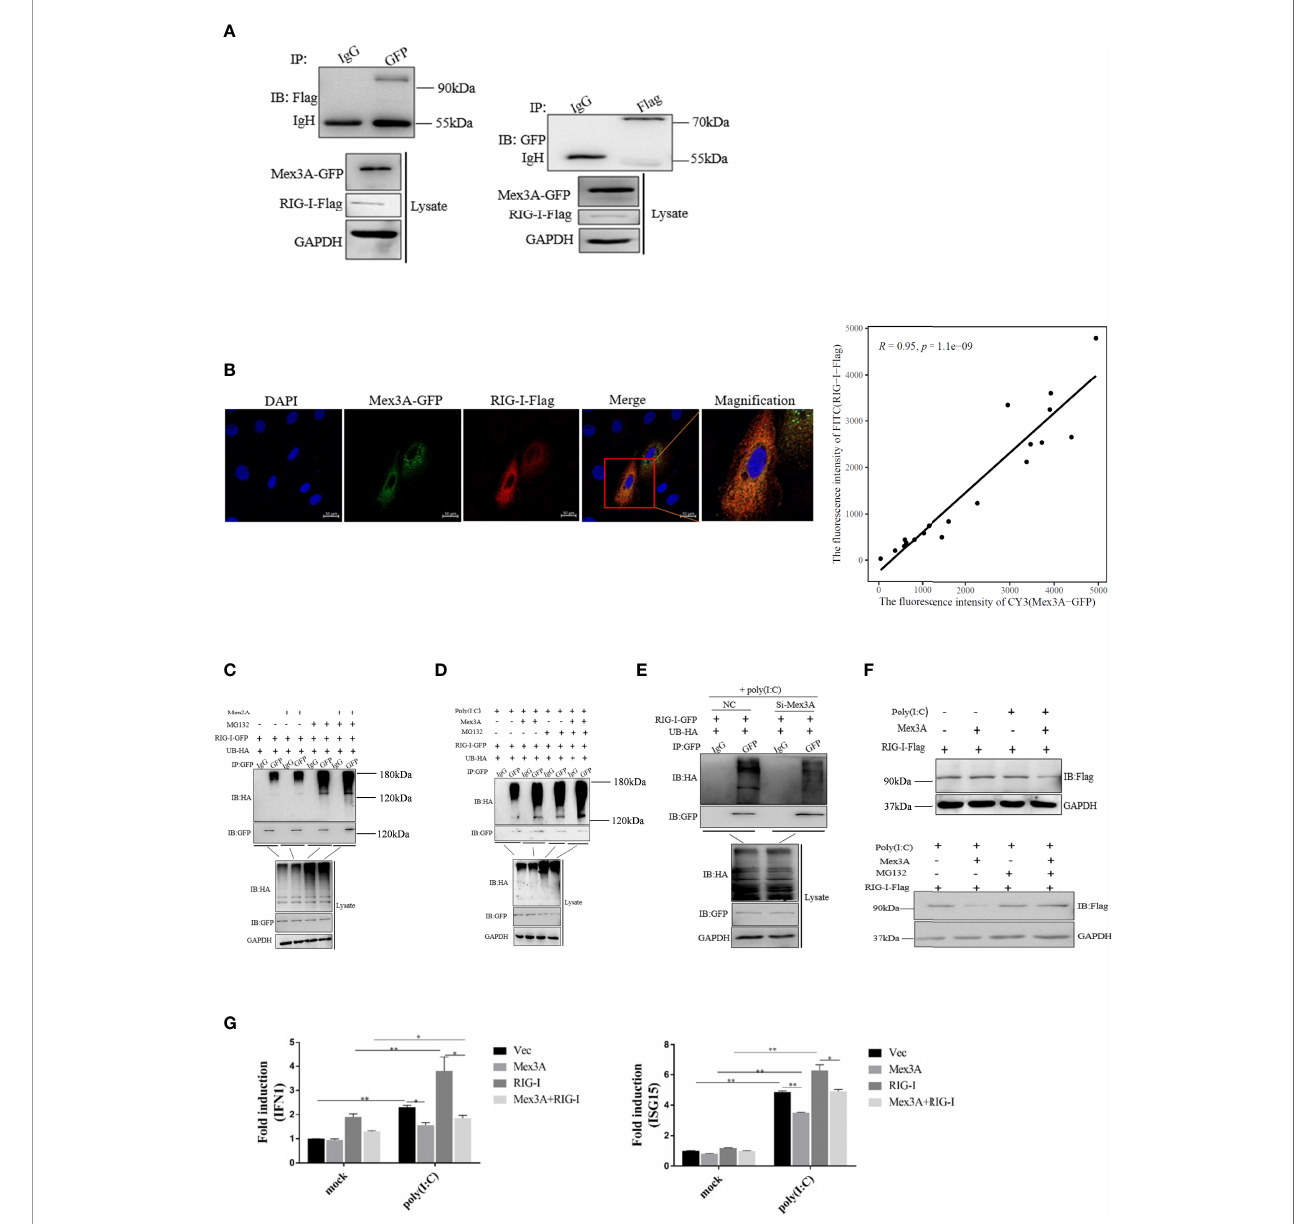
FIGURE 5 | Grass carp Mex3A promotes ubiquitination of RIG-I. (A) The interaction of Mex3A and RIG-I was analyzed with Western blotting. (B) Co-localization of Mex3A and RIG-I was examined in CIK cells. The photographs were taken on confocal microscope. Furthermore, the co-localization ratio is analyzed using Pearson ′ s coef fi cient analysis. The bars show 10 m m (C) The ubiquitination of RIG-I was analyzed by immunoprecipitation with anti-HA, followed by Western blotting analysis using the indicated antibodies. (D) The ubiquitination of RIG-I was still analyzed by immunoprecipitation and tested by Western blotting. (E) CO cells were separately transfected with 10 m l of NC or 10 m l of Si-Mex3A . The cells were treated with poly(I:C) for 6 h before ubiquitination of RIG-I was analyzed. (F) CO cells were transfected with indicated plasmids and were treated with poly(I:C) or MG132. Cells were lysed and the samples were analyzed by Western blotting with anti-Flag antibody; GAPDH antibody is used as the internal control. (G) The cells were transfected with the indicated plasmids. The expressions of IFN1 and ISG15 were analyzed by qRT-PCR like in Figure 1A . The results are from three independent experiments. Data are analyzed with ANOVA and presented as mean ± SD ( n = 3). * p < 0.05, ** p <